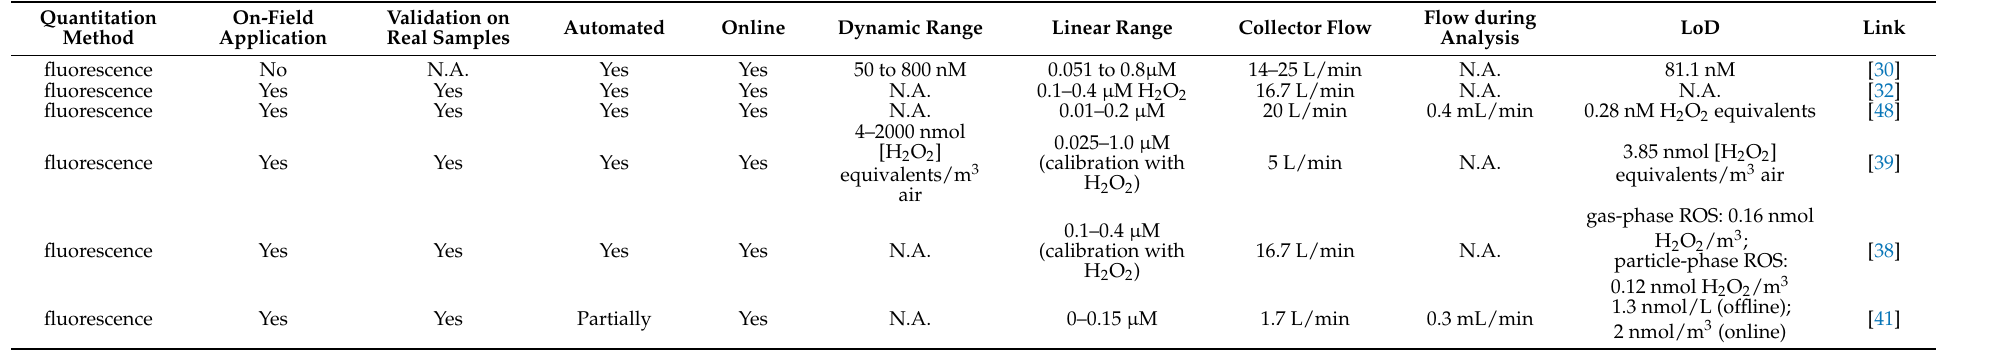
Table 1. Acellular Online Automated methods for OP PM